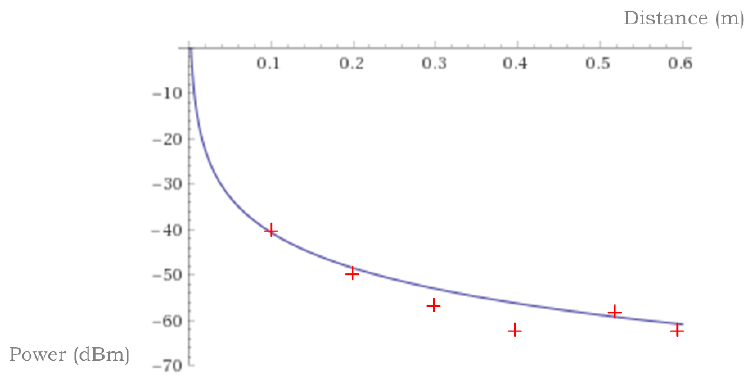
Figure 15. Fitted model with real values.